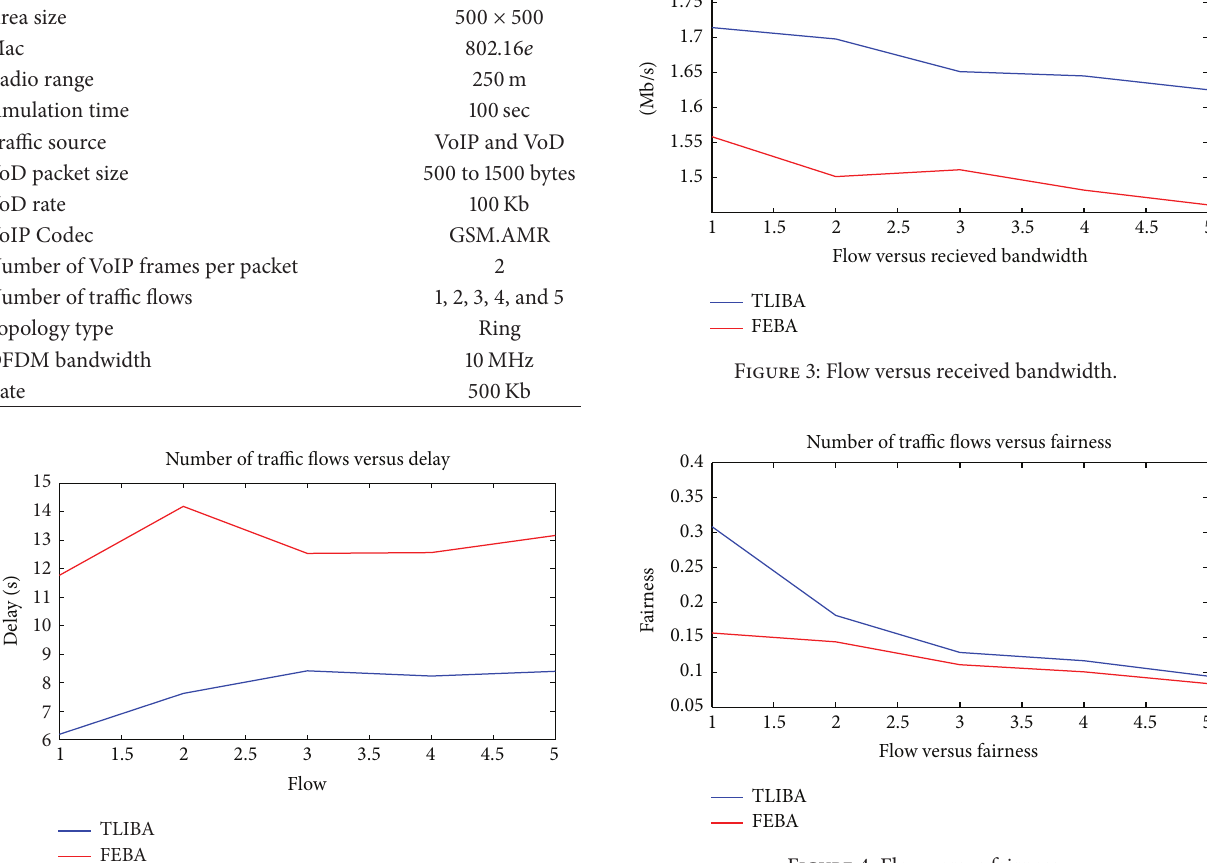
Figure 4: Flow versus